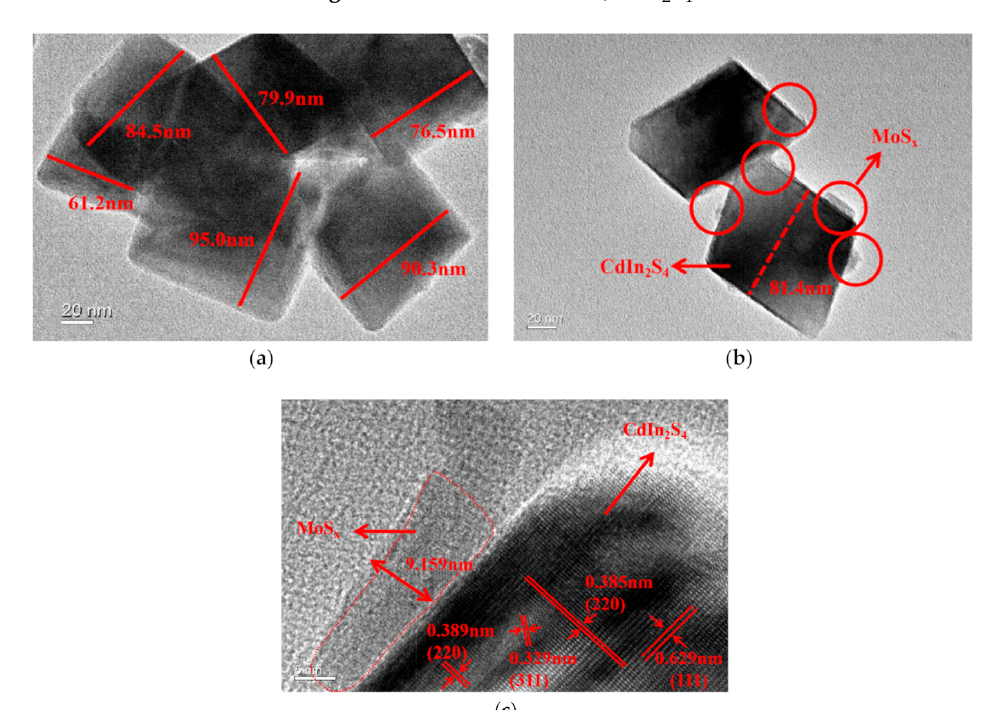
Figure 6. Transmission electron microscope (TEM) image of CdIn 2 S 4 ( a ) and MoSx / CdIn 2 S 4 ( b , c